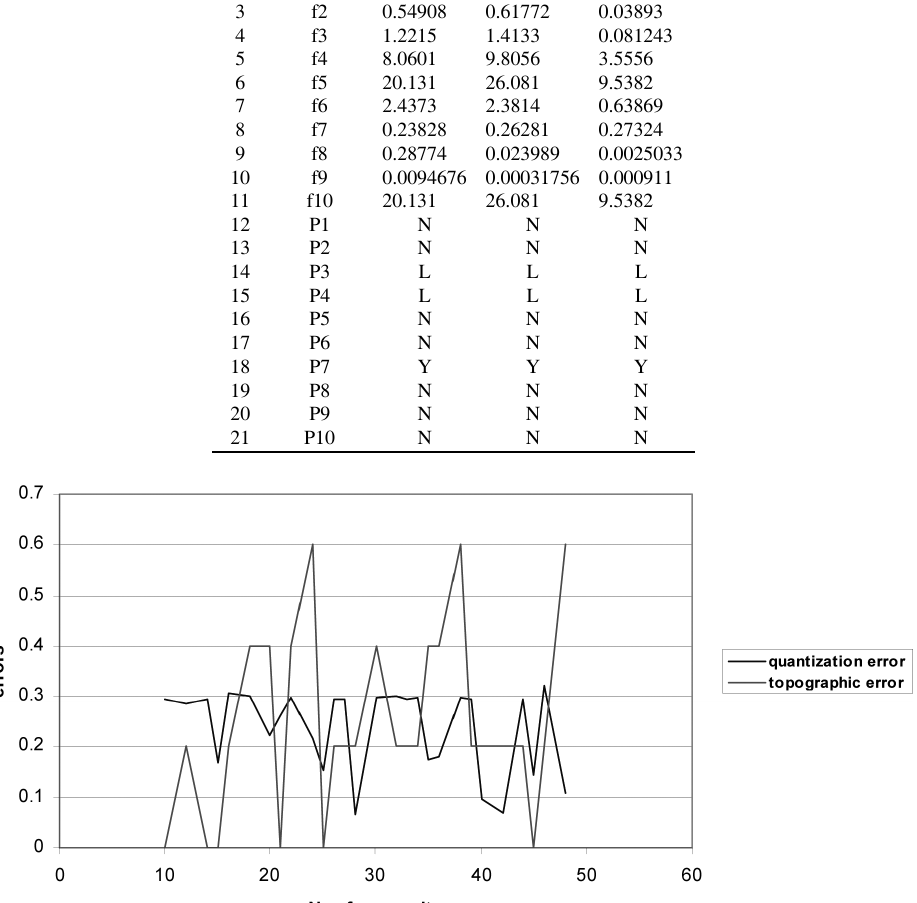
Fig. 9. Quantization and topographic errors as a function of the SOM map units. Selected optimal number of map units is 42 (6 X